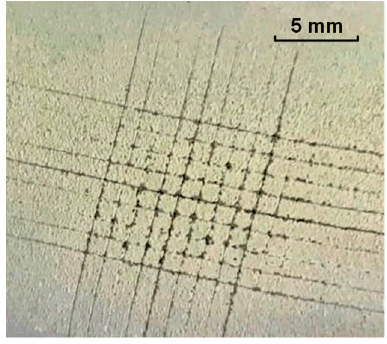
Figure 10. Surface adhesion of the super-hydrophobic surface by cross-cut tester.